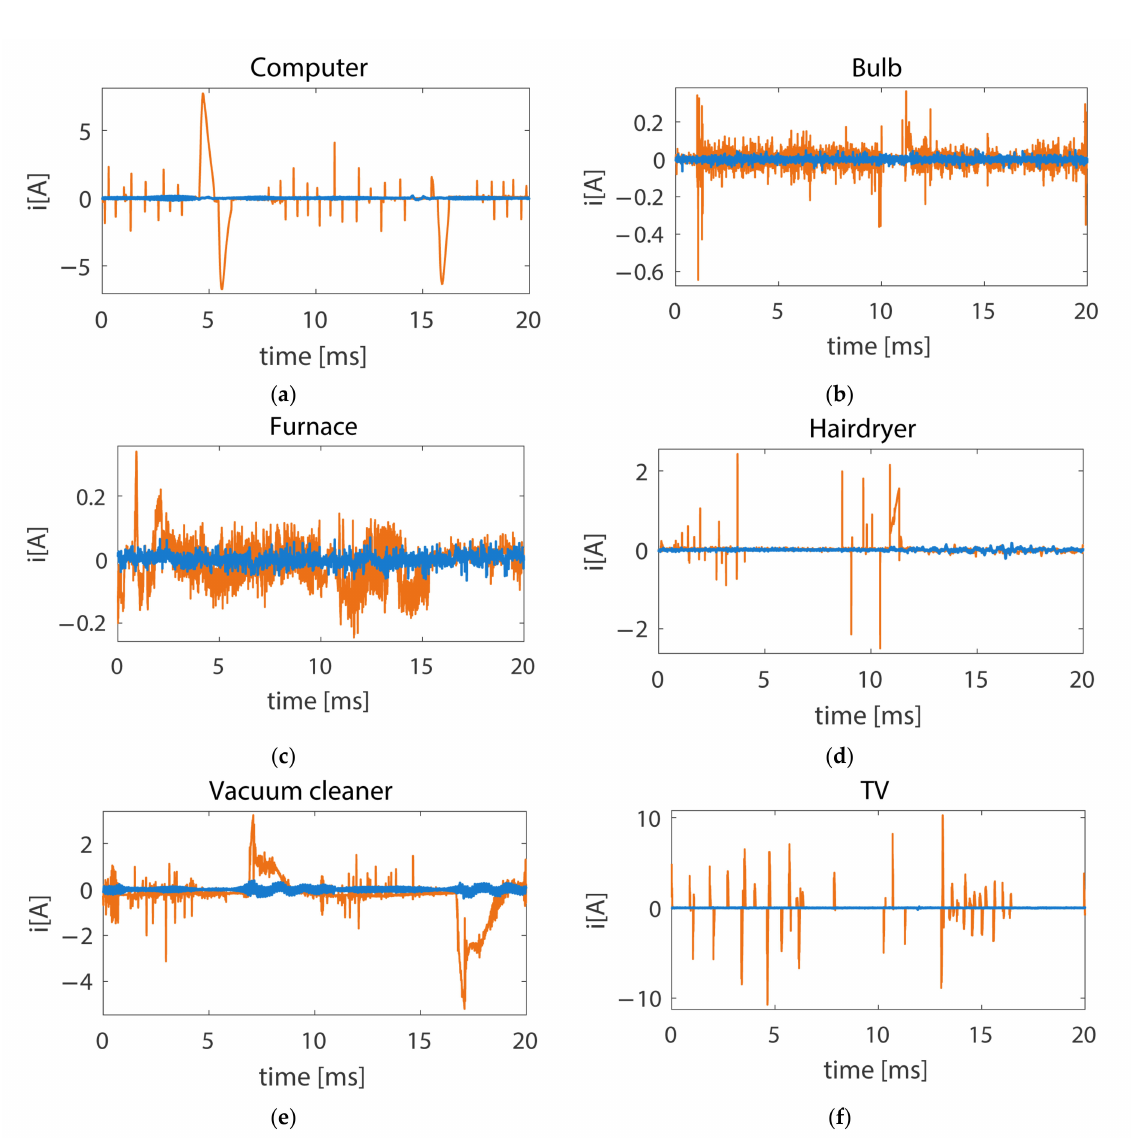
Figure 7. Changes between adjacent cycles of current signal for individually operating appliances with (orange line) or without (blue line) presence of series arc fault. ( a ) computer, ( b ) bulb, ( c ) furnace, ( d ) hairdryer, ( e ) vacuum cleaner, ( f )